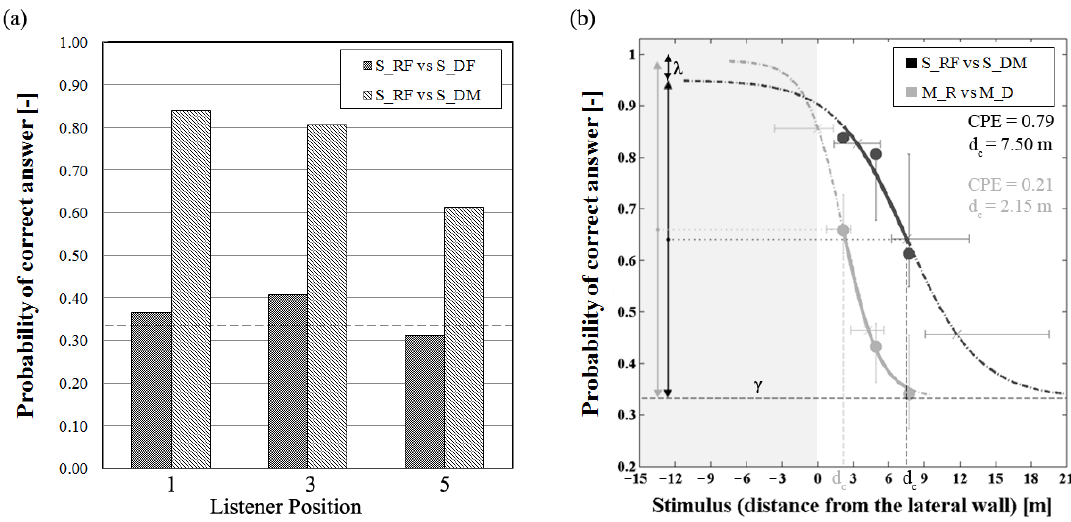
Figure 9. ( a ) Listening test results as the rate of correct answers overall the 31 subjects and three motifs in each listening position. The dark and light gray columns depict the results of the comparisons between the RF and DF conditions, and between the RF and DM conditions, respectively ( b ) Psychometric function for 31 (black) and 44 (gray) subjects and all signals, i.e., simulations and measurements tests, respectively. The black and gray circles represent the collected experimental data, i.e., the proportion of correct answers for a given stimulus intensity, the solid lines show the best-fitting psychometric function assigned to the experimental data, the vertical dashed lines highlight the corresponding threshold distance at which the presence of the diffusive surface is no longer perceived by the listeners.